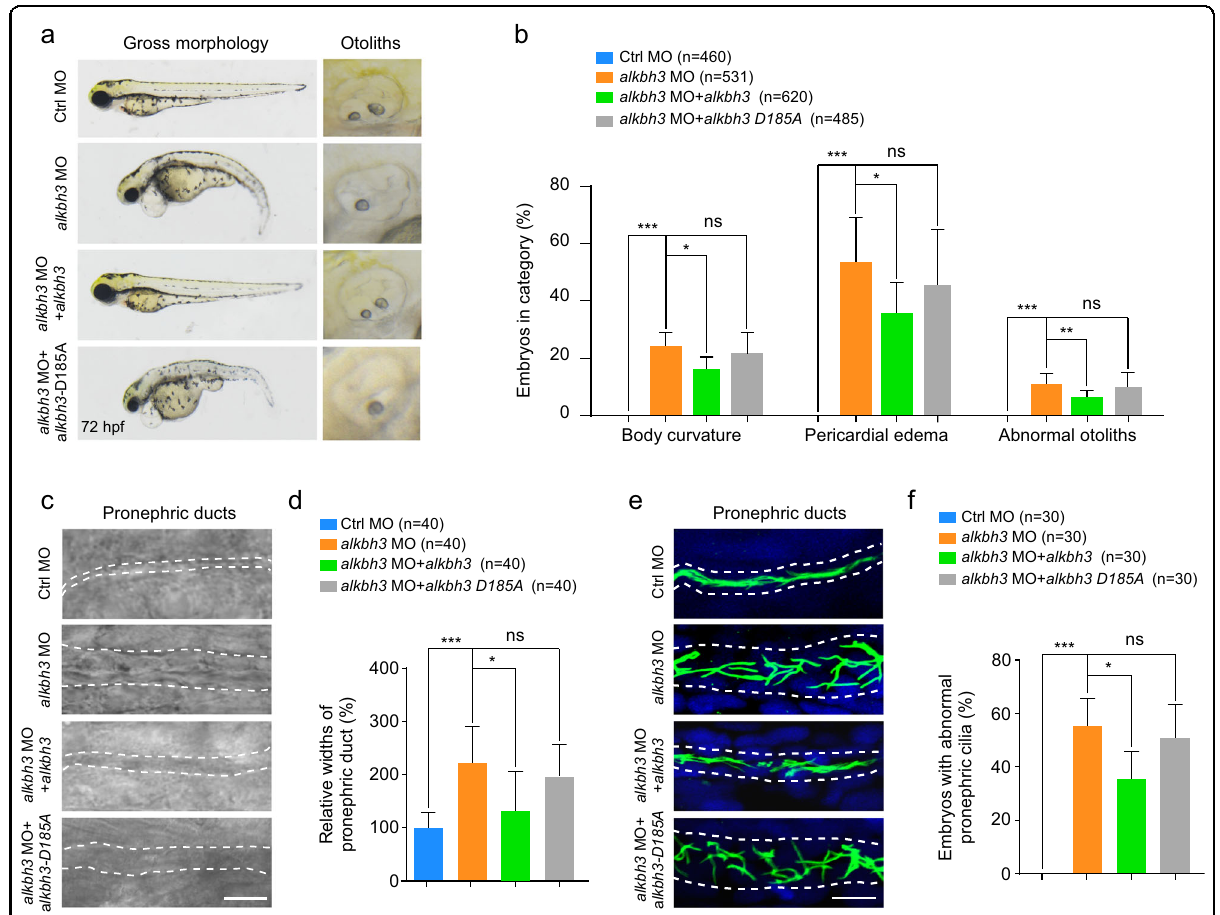
Fig. 6 Zebra fi sh alkbh3 morphants exhibit ciliary phenotypes. Zebra fi sh embryos were injected with control morpholino (ctrl MO) or alkbh3 translation-block morpholino ( alkbh3 MO) at 1-cell stage and subjected to the following analyses. a , b Bright- fi eld micrographs and statistical analysis of the ciliary phenotypes in alkbh3 morphants. c , d Representative images, and quanti fi cation of pronephric ducts in the indicated groups. The lumen of pronephric ducts is indicated by white dashed lines. Scale bar, 10 μ m. The widths of pronephric ducts in the indicated groups are measured and the median width of control morphants ’ ducts was set at 100%. e Immunostaining of cilia in pronephric ducts in morphants. Cilia were stained by anti-acetylated- α -tubulin antibody (green). The lumen of pronephric ducts is indicated by white dashed lines. Scale bar, 10 μ m. f Quanti fi cation of embryos with abnormal pronephric cilia. n, the total number of embryos in all experiments. Data are shown as the means ± SD from at least three independent experiments. Student ’ s t- test; ns, not signi fi cant; * P < 0.05, ** P < 0.01, *** P <